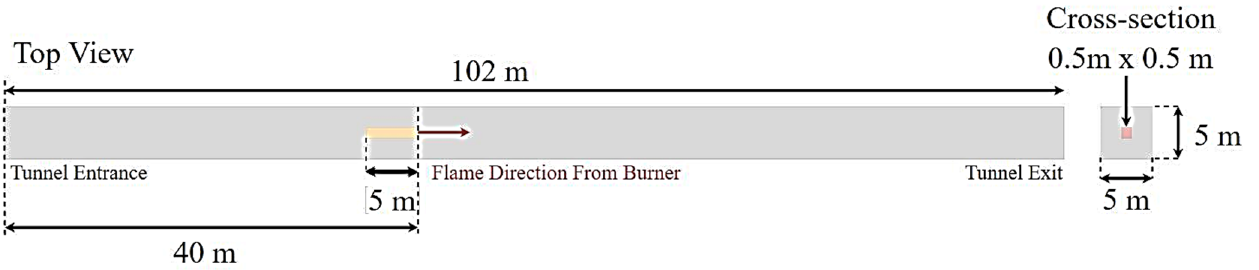
Figure 1. Schematic view of the dimensional